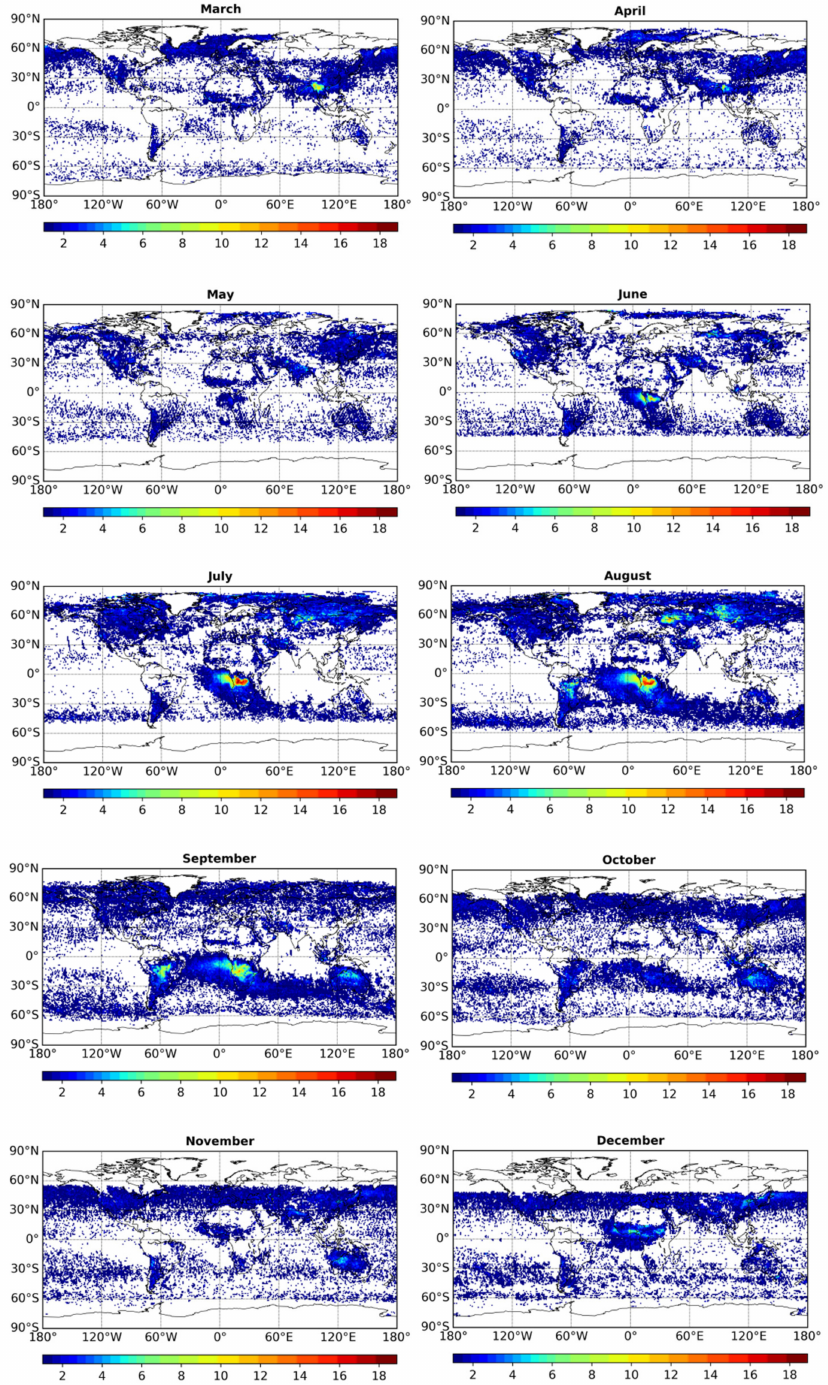
Figure 4. Global distribution of the monthly absolute frequency of occurrence of absorbing carbonaceous aerosols (in number of days /